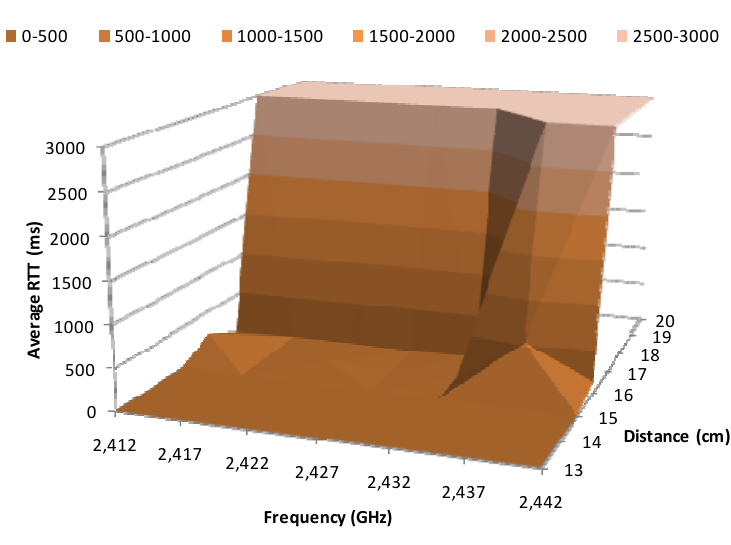
Figure 8. Average RTT for 1